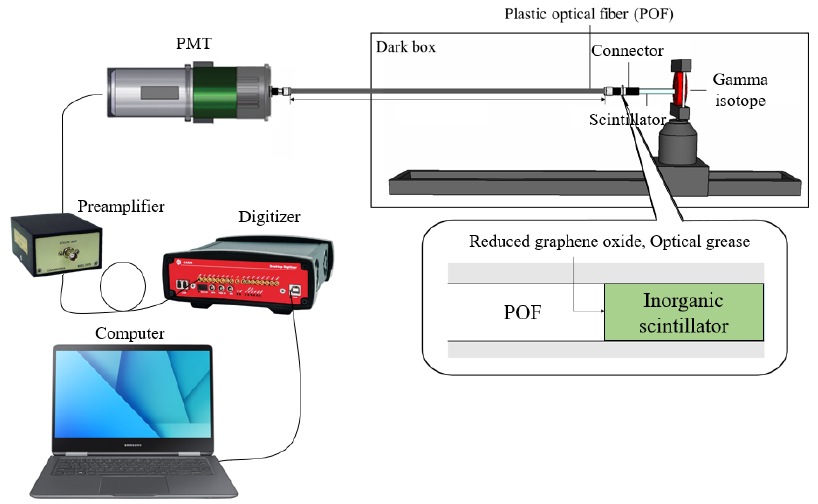
Figure 2. Experimental setup for measuring gamma-ray spectroscopy.